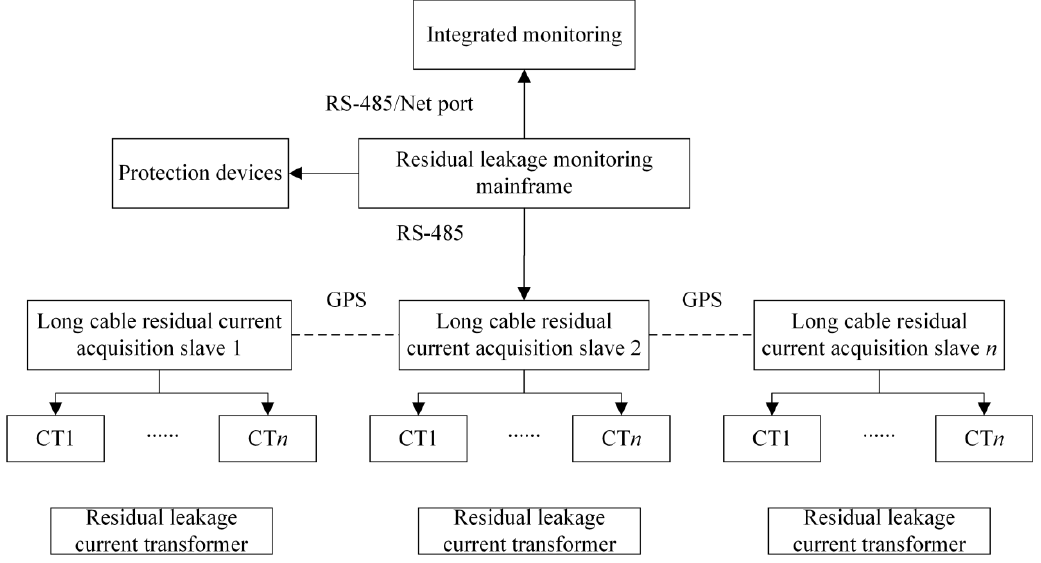
Figure 1. The residual current monitoring scheme.